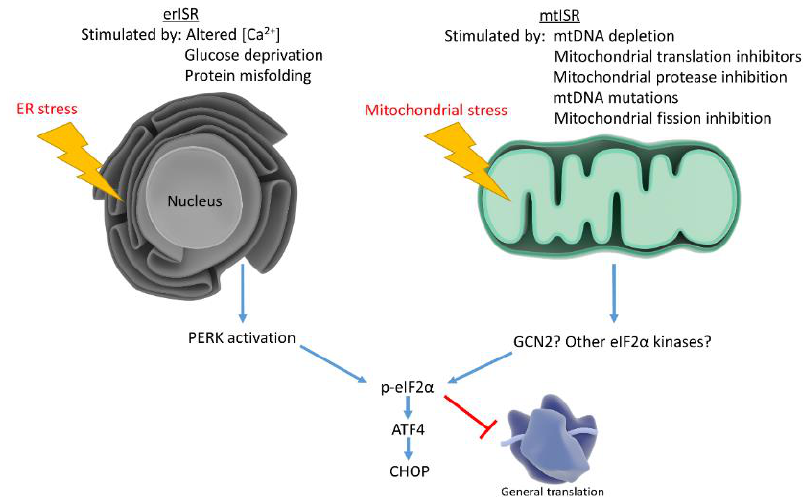
Figure 2. Mitochondrial stress and ER stress stimulate the ISR, which reduces general protein translation while upregulating stress responsive factors. ER stress activates the ISR through PERK, while mitochondrial stress may activate the ISR through multiple eIF2 α kinases.